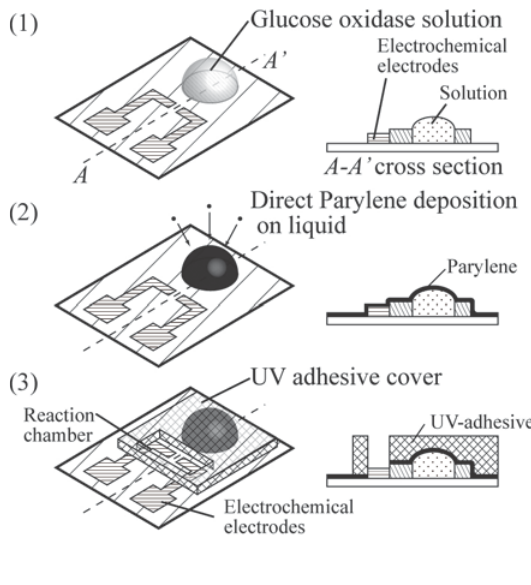
Figure 1. Concept and